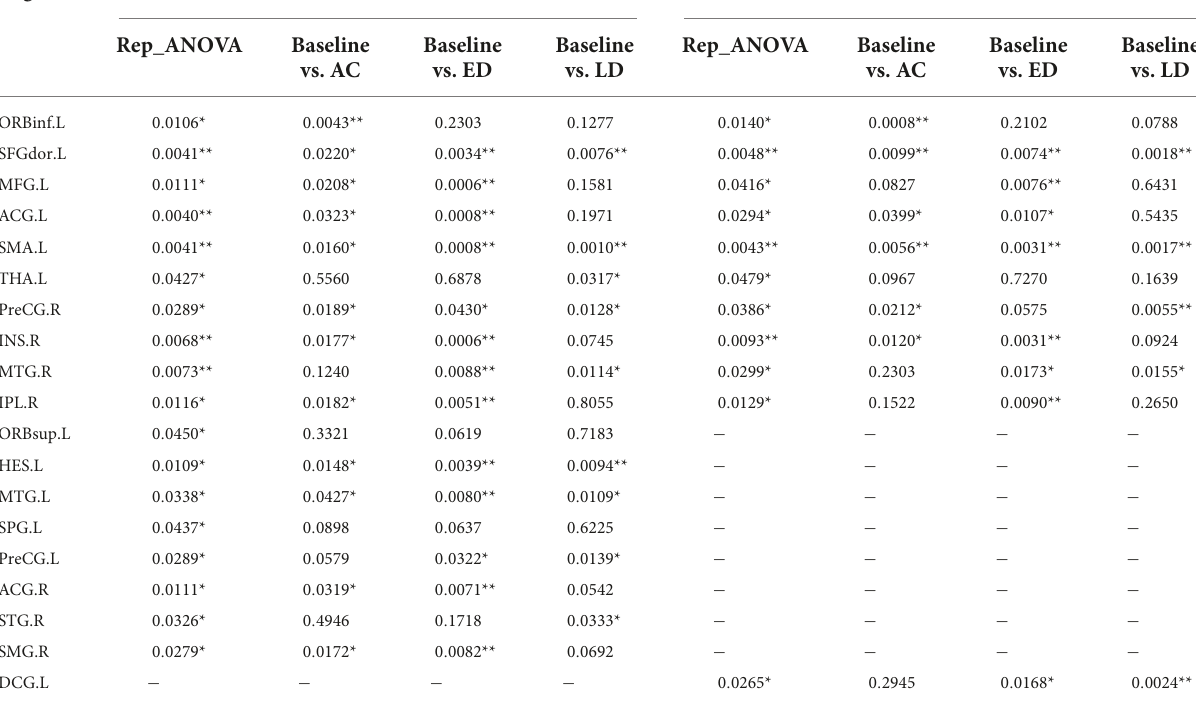
TABLE 2 The statistical results of regional analysis for nodal efficiency and degree centrality. Regions NE DC Rep_ANOVA Baseline Baseline Baseline Rep_ANOVA Baseline Baseline Baseline vs. AC vs. ED vs. LD vs. AC vs. ED vs.